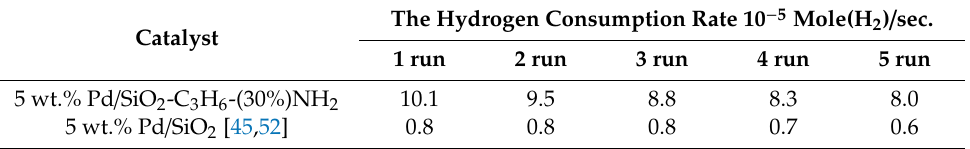
Table 4. Catalytic recyclability test for a successive five cycles of 4-nitroaniline hydrogenation. The hydrogen Consumption Rate 10 − 5 Mole(H 2 )/sec. Catalyst